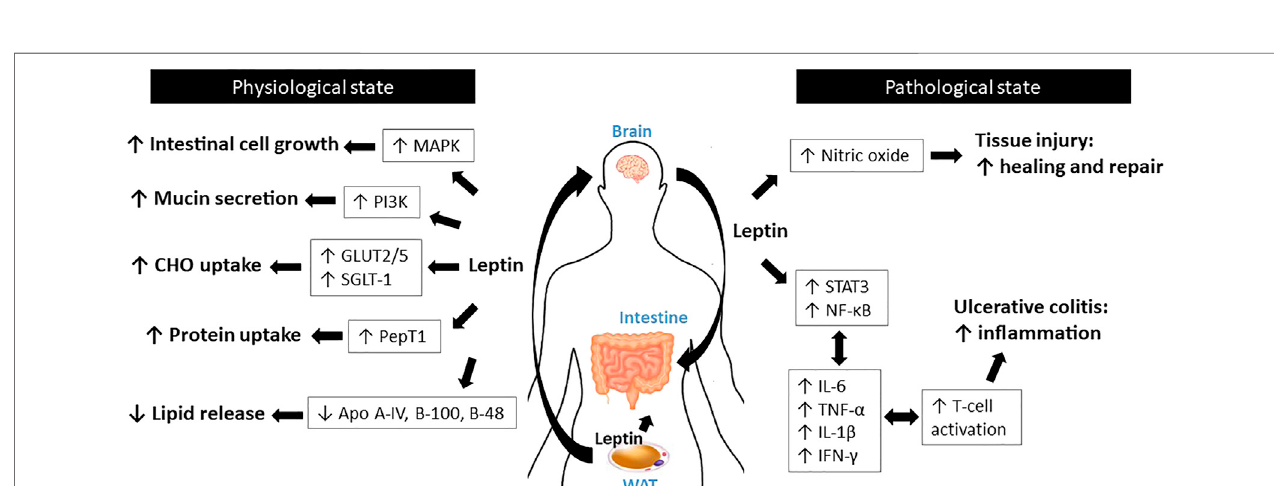
FIGURE 2 | Schematic diagram for the roles of leptin in the intestine.